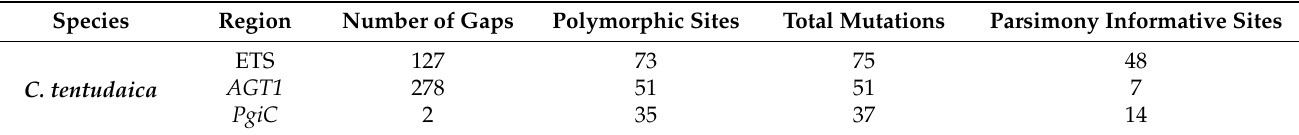
Table 2. Polymorphic site data of the ETS, AGT1 , and PgiC